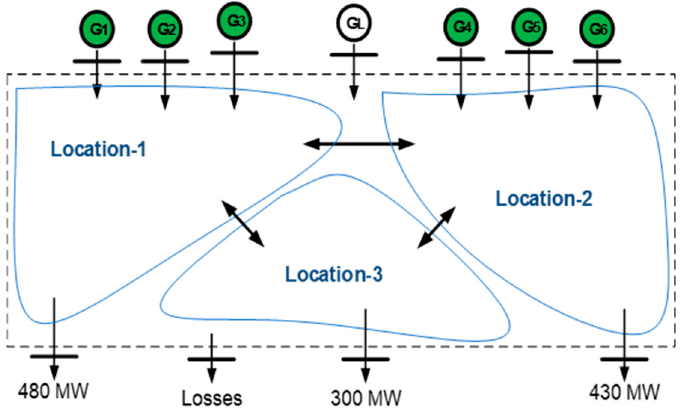
Figure 4. The system consisting of three locations.